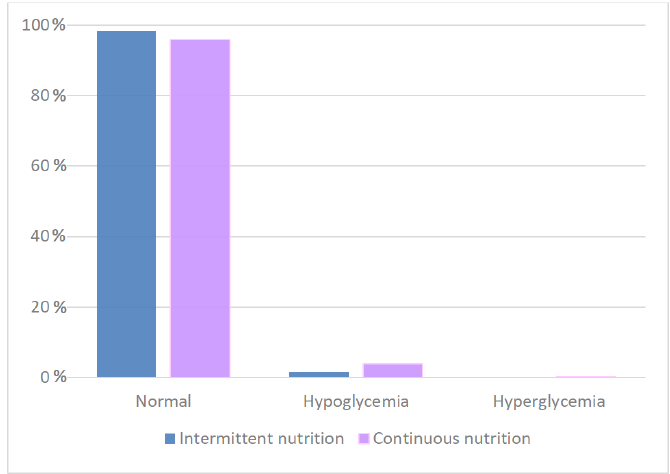
Figure 3. Correlation between glycaemia and type of nutrition: most of the detected blood glucose values were in the reference range. In the continuous feeding group, the incidence of hypoglycemia was higher.